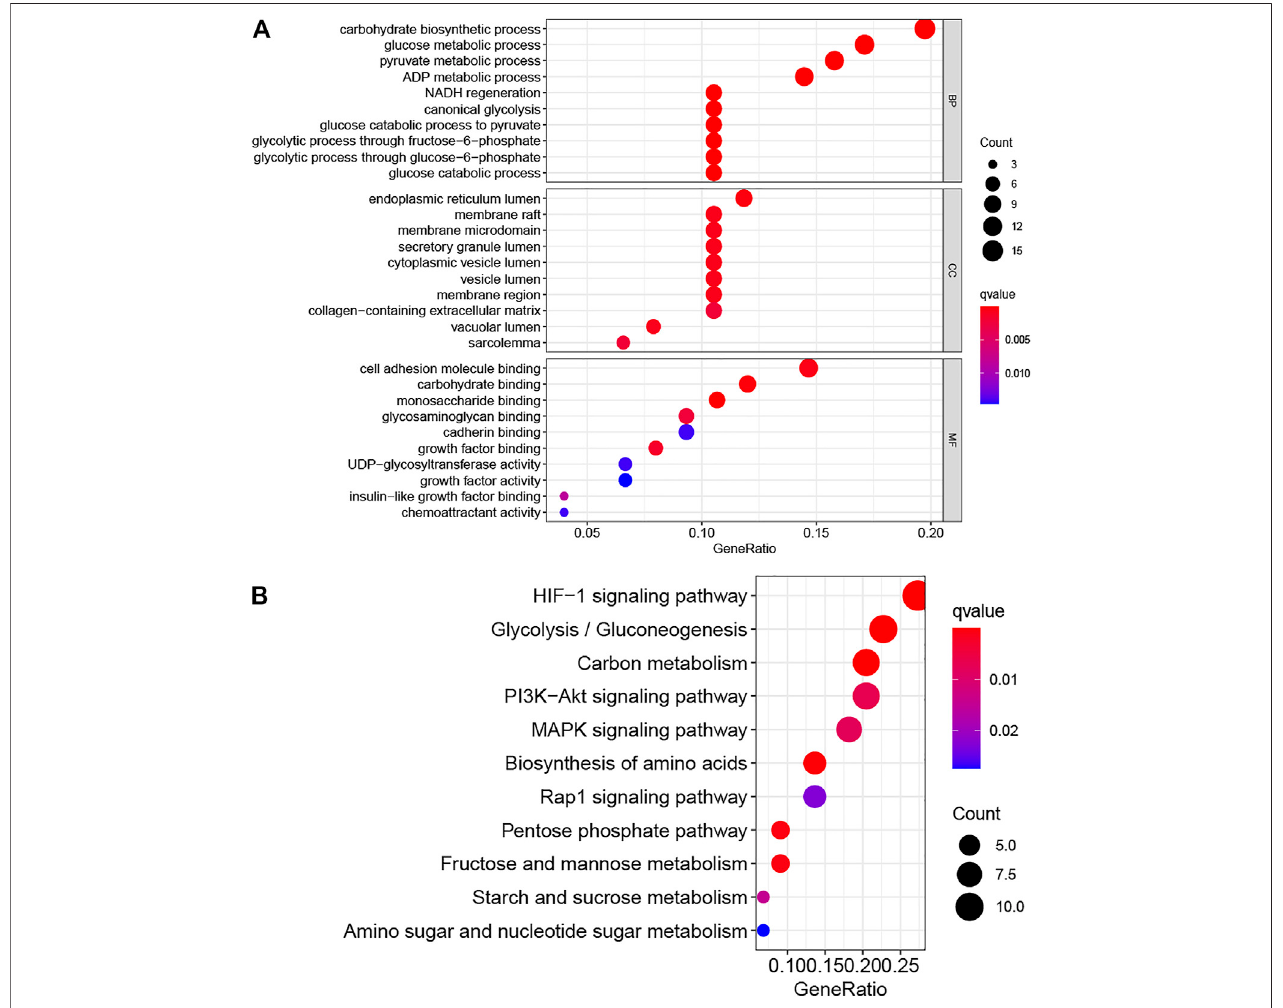
FIGURE 1 | GO (A) and KEGG (B) analysis for hypoxia-related differentially expressed genes.